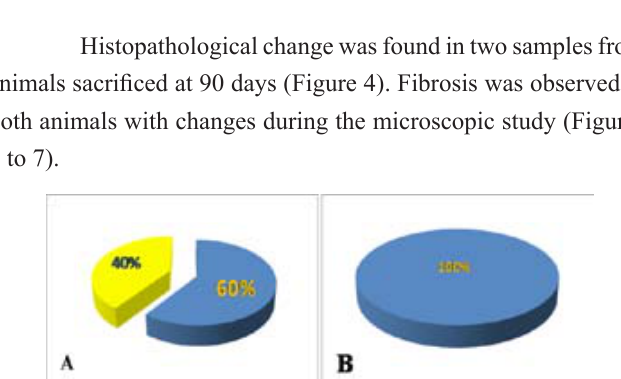
FIGURE 3 – Weight in grams of the fat resected from the dorsum. The number two and five rabbit showed histopathological alteration in microscopy